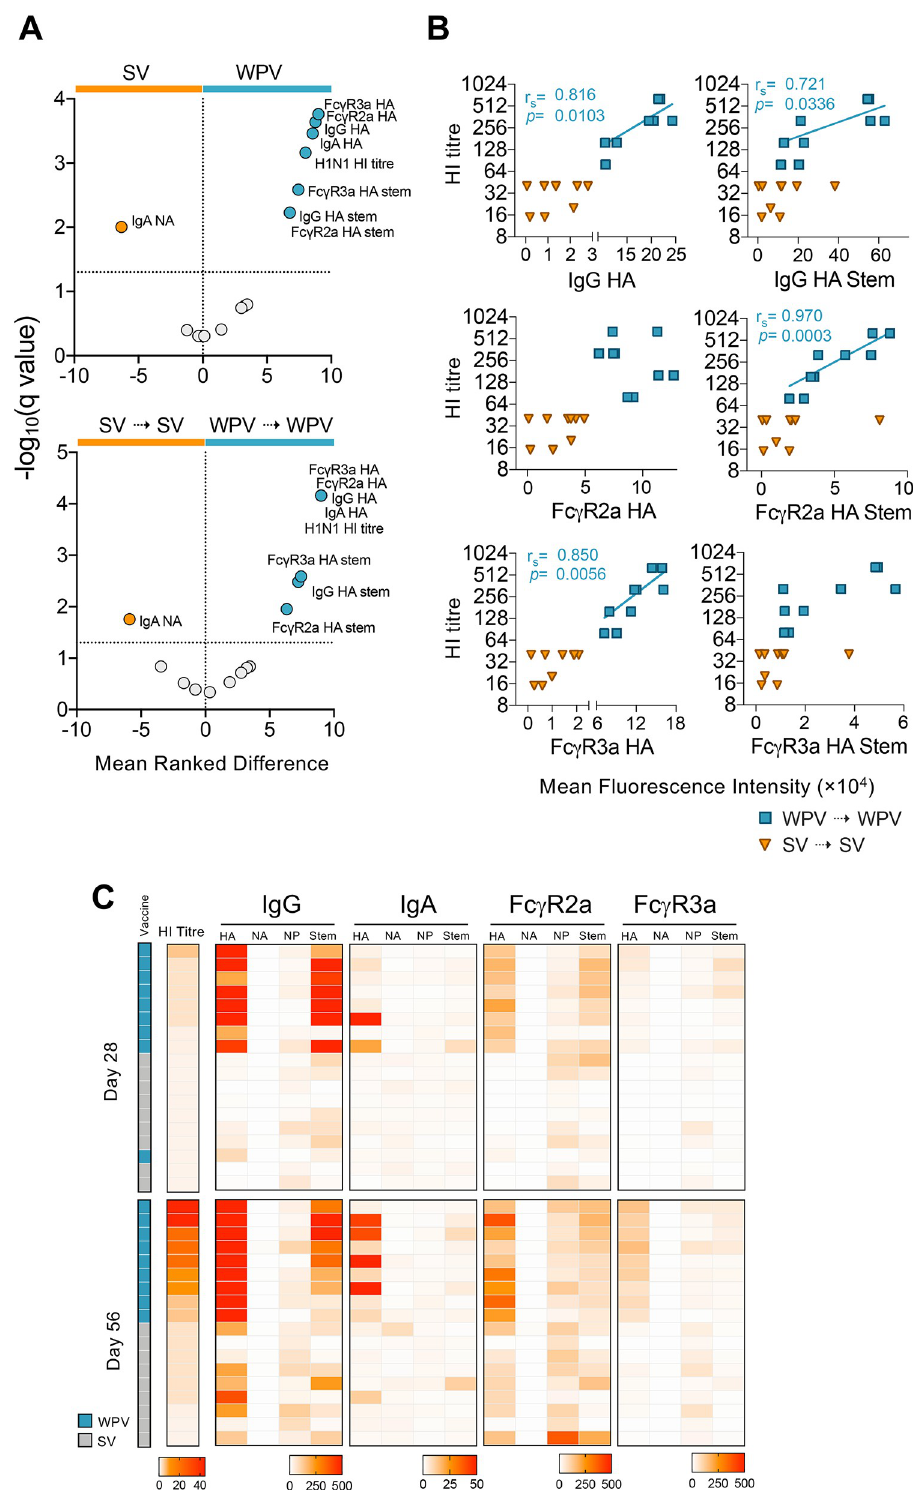
Fig 2. HI titres induced by WPV strongly correlate with IgG responses and Fc γ R usage against H1N1 antigens. (A) Volcano plots of 17 humoral immune parameters following either one (SV or WPV) or two doses (SV ⇢ SV or WPV ⇢ WPV) of monovalent vaccine are shown. Mean ranked differences and q values were determined using Mann- Whitney tests of Log-transformed data, with a false discovery rate < 5% considered statistically significant. (B)